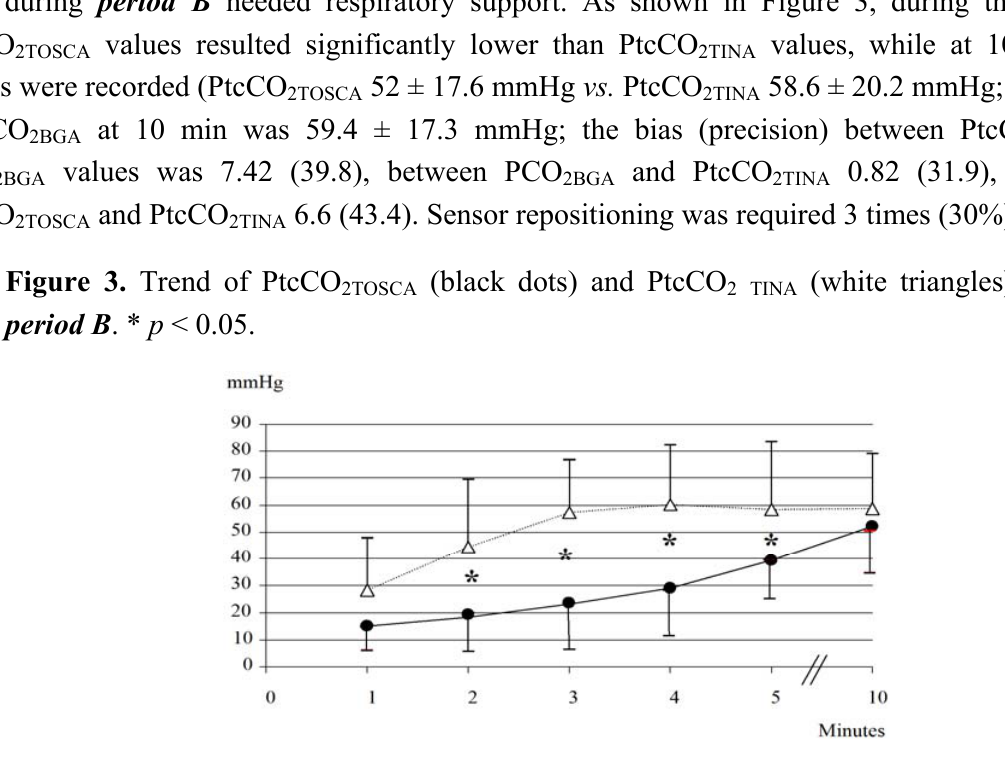
Figure 4. Trend of SpO and trend of PtcCO